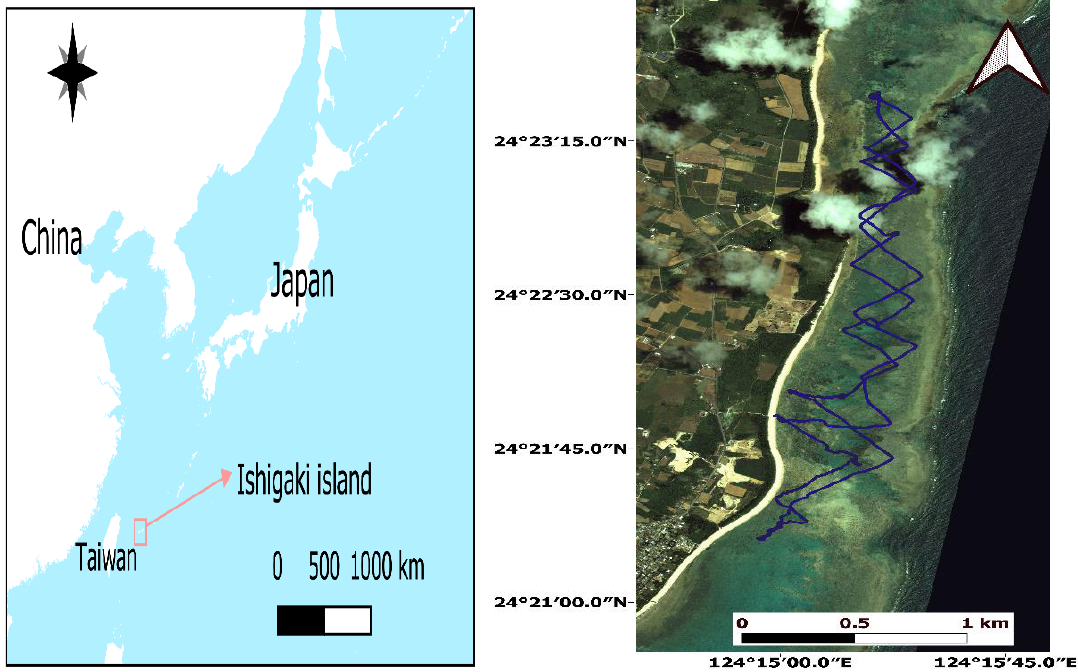
Figure 1. The Location of Shiraho study area Ishigaki Island, Japan. The blue line represents the field surveyed path (Quickbird satellite image).